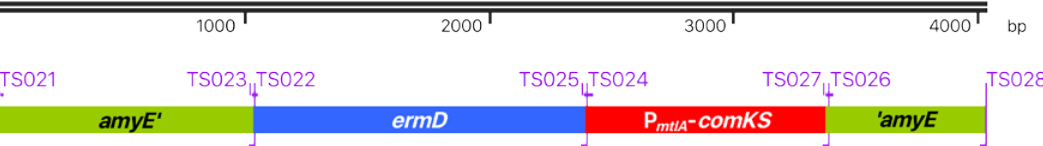
Table 1. Transformation efficiency of the B. subtilis strains Δ6, REG19, and TS01.